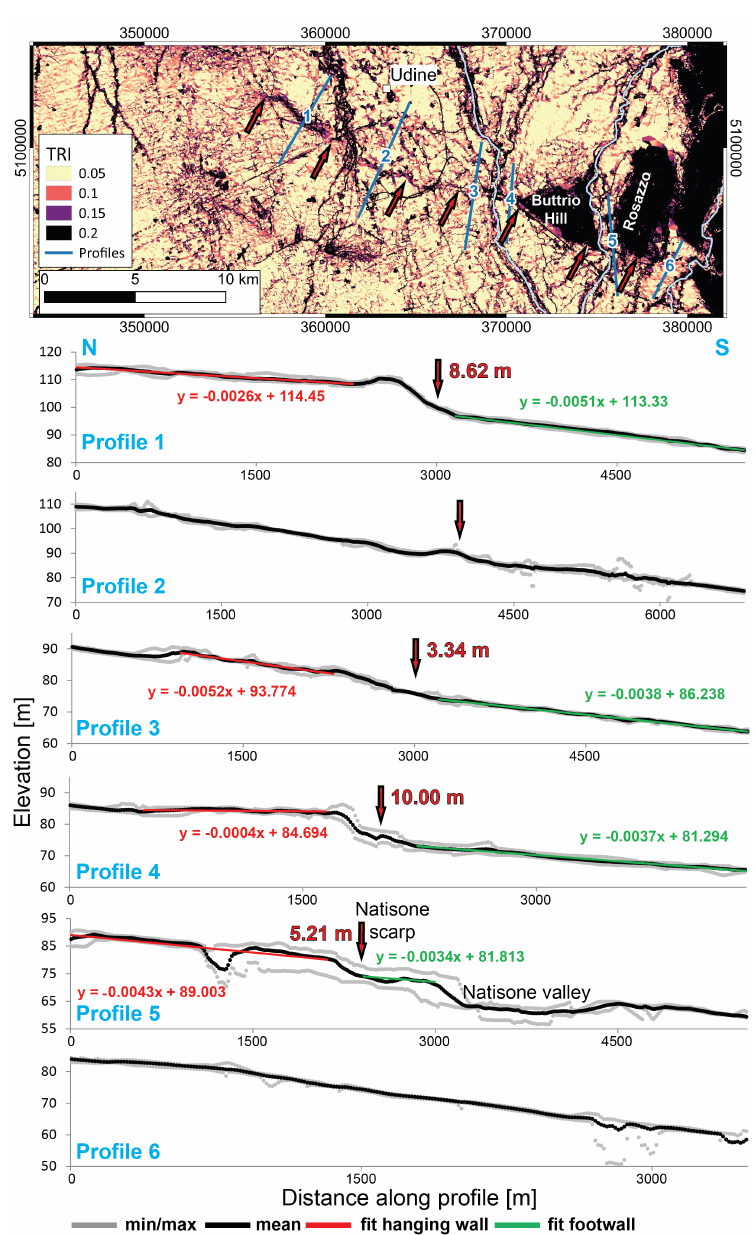
Figure 3. Terrain ruggedness index (TRI) map of the study area based on the 10 m TINITALY DEM. The trace of the Udine-Buttrio Thrust is visible as a band of elevated TRI values. The triangular artefacts are due to the used DEM. Note that the colour scale of the TRI values saturates at a value of 0.2 in order to visualize faint geomorphic features. The red arrows mark the fault scarp and the blue numbered lines refer to the topographic profiles shown below. The six swath profiles sample a 500 m-wide band of the DEM (250 m on either side of the profile trace) with 50 parallel tracks. The grey lines mark the minimum and maximum elevations extracted and the thick black line represents the mean. The red and green lines are linear trends fitted to subsets of the mean data in the hanging wall and the footwall of the fault, respectively, with their equations. The red arrows indicate the location of the fault scarp as visible in the TRI map and the red numbers next to the arrows are the vertical offsets calculated at that profile distance using the equations of the linear fits. The vertical offsets vary significantly along strike from 0 m to 10 m, and profiles 3 and 4 show folding of the hanging wall. All the profiles are vertically